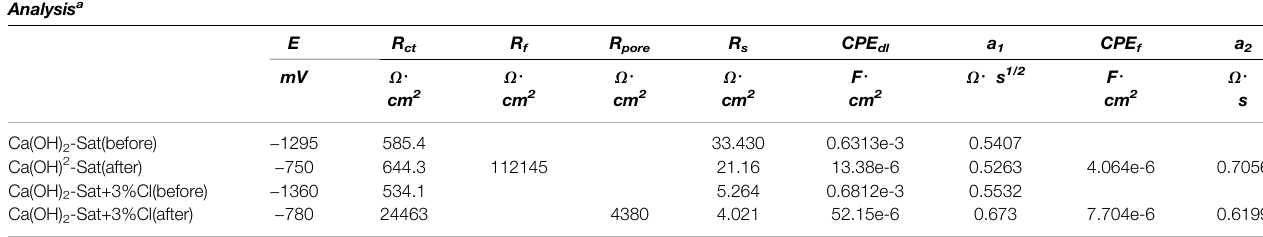
TABLE 5 | Z fi t analysis of the experimental EIS data of zinc plates in the two test solutions. Z fi t Analysis a